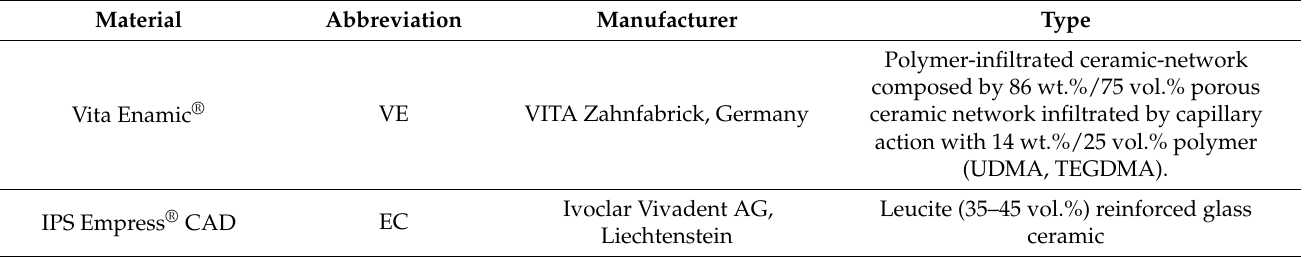
Table 1. Composition of the studied materials from their manufacturers’ technical